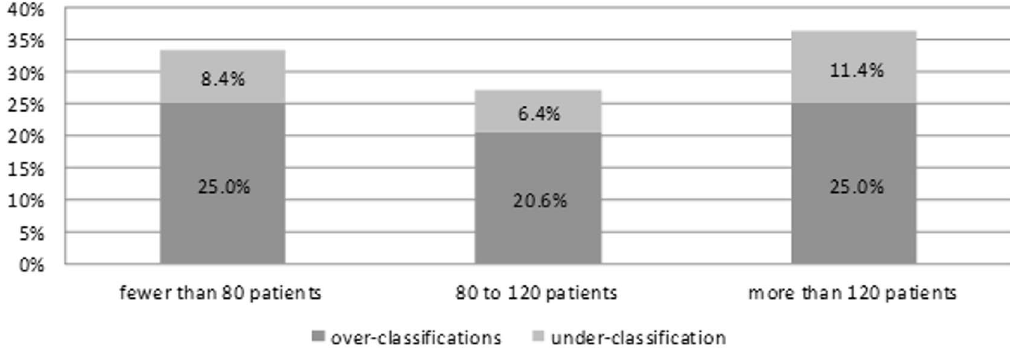
Figure 3. Effect of number of COPD patients seen in a month on a discrepancy between subjectively classified patients into GOLD 2011 groups and classification achieved by objective assessment using software.